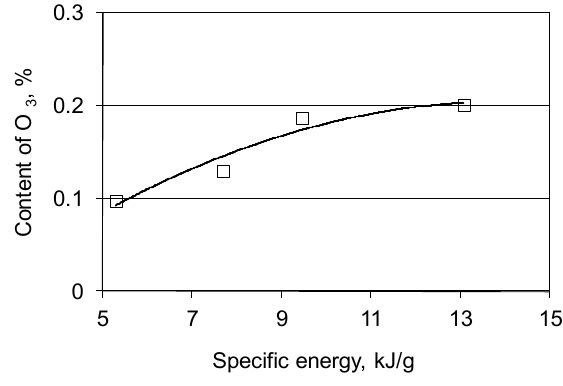
content and specific energy 3